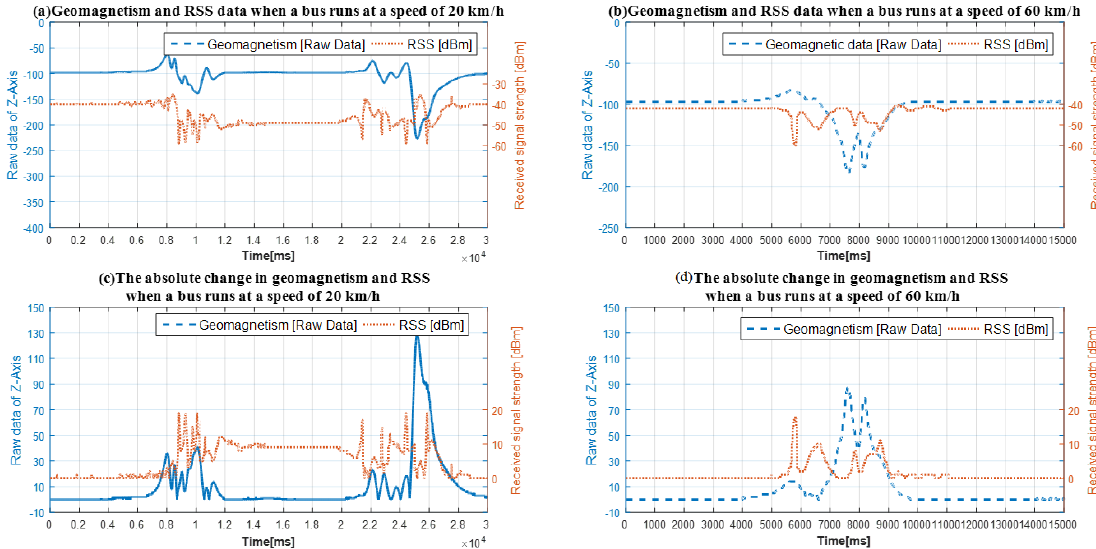
Figure 4. The geomagnetism and RSS data when a bus runs at different